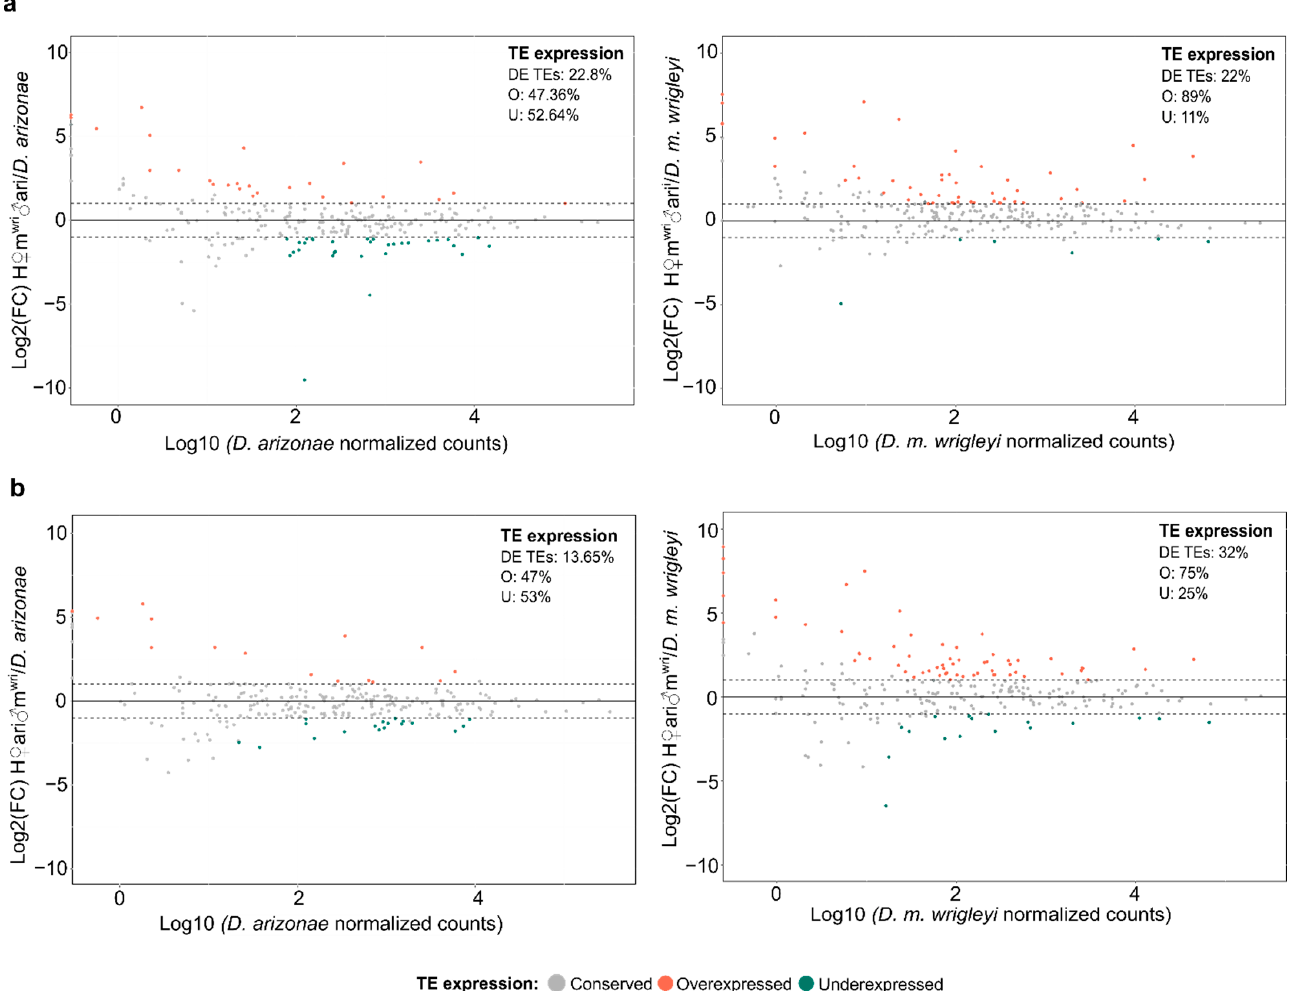
Figure 4. TE expression in testes of hybrids vs. parental lines. ( a ) log2 of the ratio (counts in H ♀ m wri ♂ ari/counts in parental lines ( D. arizonae and D. m. wrigleyi )); ( b ) log2 of the ratio (counts in H ♀ ari ♂ m wri /counts in parental lines ( D. arizonae and D. m. wrigleyi )). Dotted lines represent Log2(FoldChange) > |1| and p -value adjusted < 0.05. DE TEs: deregulated TEs; O: overexpressed TEs; U: underexpressed TEs.